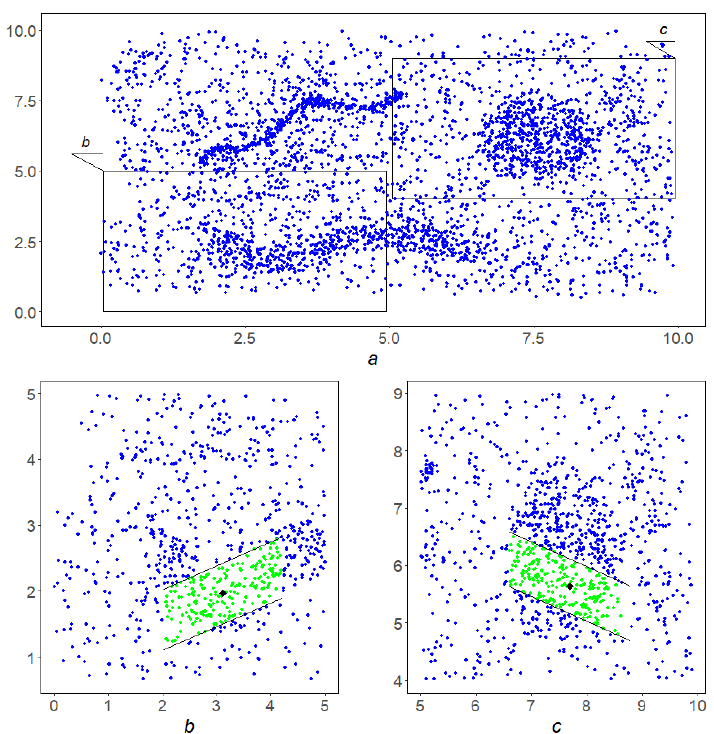
Figure 12. The first stage of the LDPS algorithm. ( a ) original array; ( b ) a corridor with a separability equal to 0.64; and ( c ) a corridor with a separation of 0.5. The position of the fragments of the original array shown in figures ( b , c ) is indicated by the leaders in figure ( a ).